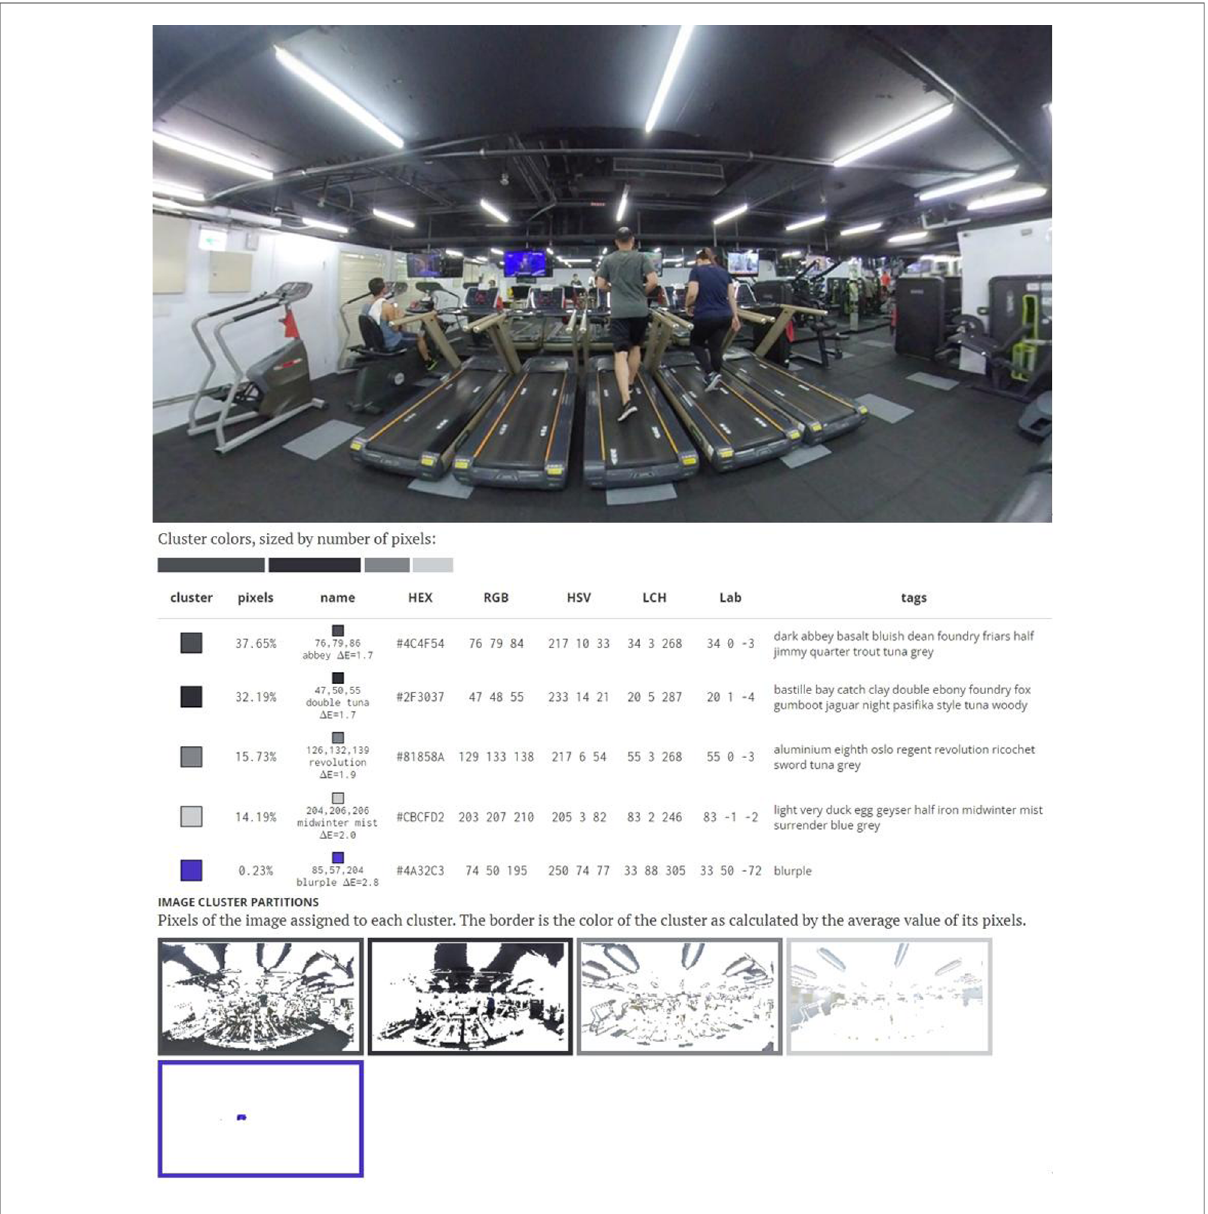
FIGURE 3 Indoor walking environment colour analysis